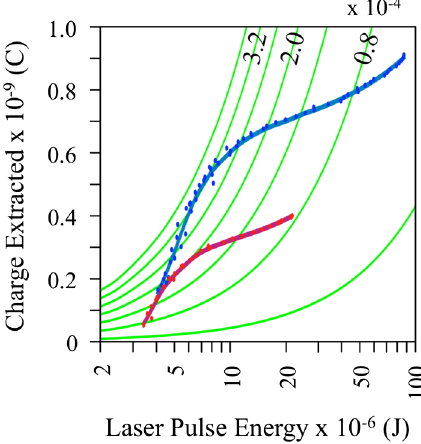
green.FIG. 4. Unusual dependence of charge extracted from CsBr on laser pulse energy for two different laser spot sizes, each taken at 80 MV = m field, − 60 ° rf-laser phase. Data from the smaller spot are colored red and the larger spot are colored blue. Lines of constant quantum efficiency are colored